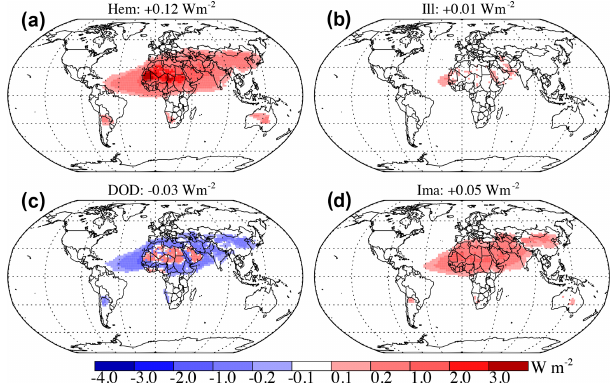
Figure 9. High-branch uncertainty in TOA shortwave DRE Wm − 2 induced by uncertainty in hematite ( a , hem), illite ( b , ill), DOD (c) , and imaginary complex refractive index ( d , ima) in CAM5. All sim- ulations used here are based on C1999. Numbers in the title denote global mean deviation from the baseline in CAM5. Values are cal- culated at each grid box as the difference between DRE from the high-bound soil mineralogy case and the baseline.